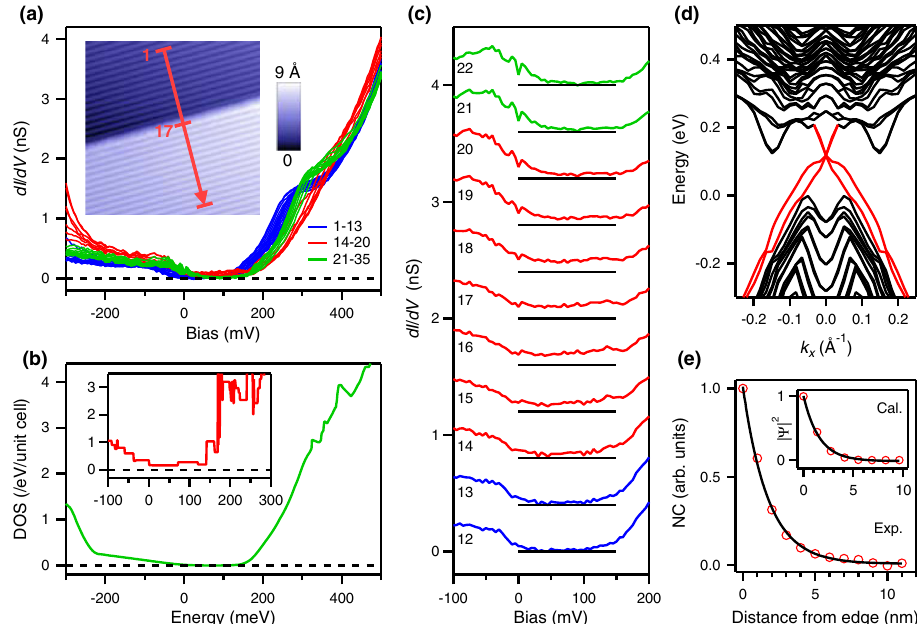
FIG. 4. (a) Tunneling differential conductance spectra along a line perpendicular to a monolayer step edge ( I ¼ 500 pA, V ¼ 500 mV). Red curves are tunneling spectra measured near the step edge, while the blue and green curves are measured away from the step edge on the lower and upper terraces, respectively. The inset shows the topographic image of the step ( I ¼ 30 pA, V ¼ 300 mV) and data point locations. (b) Calculated DOS of the top monolayer. The inset shows the calculated DOS of the edge states of the monolayer along the chain direction. (c) Evolution of the edge states. For clarity, the spectra from the 12th to 22nd points are offset with equal intervals of 0.4 nS. Black lines indicate the zero-conductance level for each spectrum. (d) Calculated band dispersions of the edge states of the monolayer along the chain direction. (e) Normalized conductance integral within the gap plotted as a function of the distance from the edge. The black curve is an exponential function fit to the data with a characteristic decay length ξ ¼ 1 . 5 nm. The inset plots the calculated mode of the wave function for the edge state close to Γ as a function of the distance from the edge. The black curve is an exponential function with a characteristic decay length ξ ¼ 1 . 6